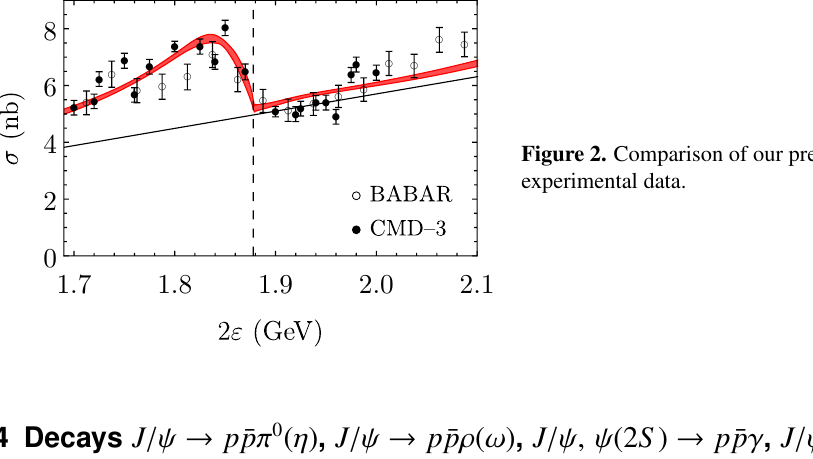
Figure 2. Comparison of our predictions with the experimental